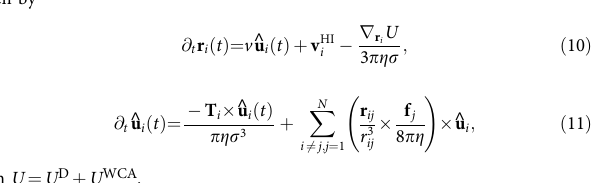
Figure 10 | Spontaneous fusion and fission for ring-like clusters with opposite vorticity. ( b ) Emerging states for all swimmer types as a function of reduced self-propulsion velocities v / v 0 —see Supplementary Movies 7–9. Each state is depicted in a sketch in panel a and can characterized by: (i) a non-rotating but translating coupled dimer, (ii) a counter rotating microswimmer chain orbiting around a ring of N ¼ 8 swimmers (iii) toddling and rotation, where the former rings exchange swimmers and translate, (iv) an emerging ring containing all N ¼ 10 swimmers as well as (v) collision induced and (vi) spontaneous fission of the ring-like